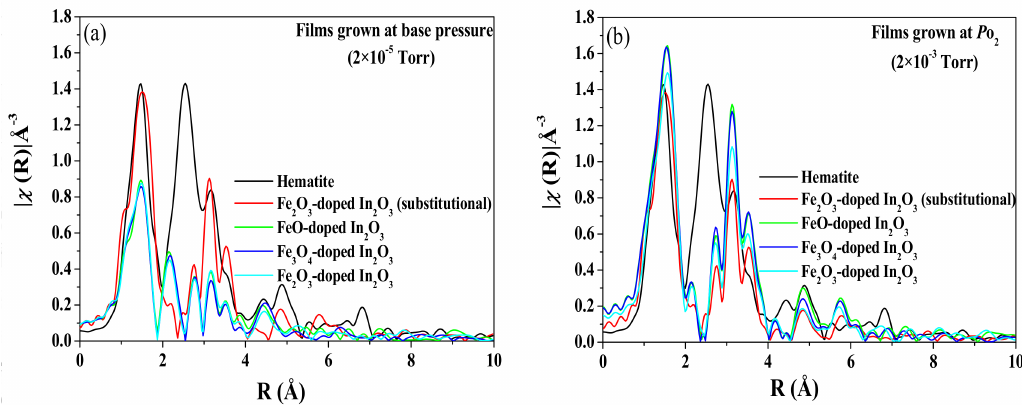
Figure 3. X-ray absorption fine structure (EXAFS) Fourier transform of Fe 2 O 3 and substitutional Fe 2 O 3 -doped In 2 O 3 deposited at base pressure as reference compounds and the Fe-doped In 2 O 3 films grown from di ff erent precursors at ( a ) base pressure of 2 × 10 − 5 Torr and ( b ) O 2 pressure of 2 × 10 − 3